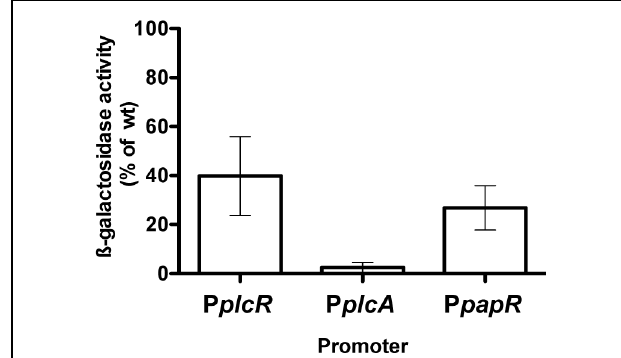
FIGURE 1 | Expression of PlcR-dependent genes in Bt (cid:2) codY compared to the wild-type strain. (cid:2) codY and wild-type cells harbor a transcriptional fusion between the promoter of interest and the lacZ gene. Cells were grown in LB at 37 ◦ C and harvested 2 h after entry into stationary phase. The β -galactosidase specific activity was then assayed. The results are the mean values of at least two independent experiments, and the error bars represent standard deviation.